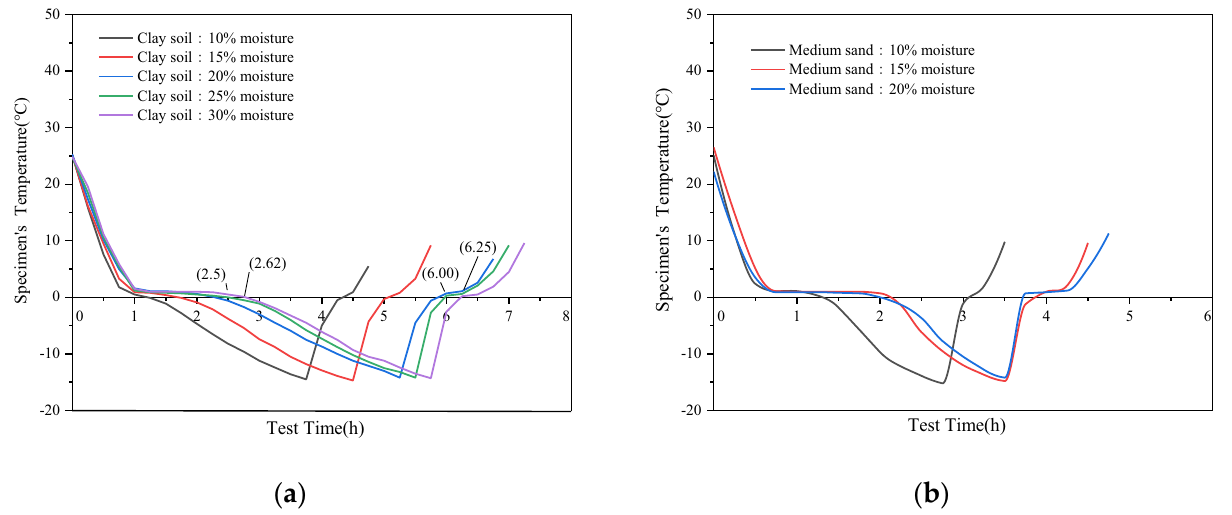
Figure 2. Temperature change of samples with different moisture content. ( a ) Temperature change of clay samples with different moisture content;( b ) Temperature change of medium-sand samples with different moisture